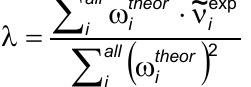
Figure 1. Organophosphates I - III